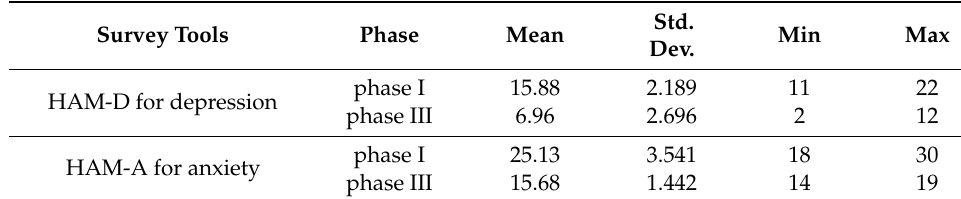
Table 4. Depression and anxiety scores in the two studied phases ( N = 120).